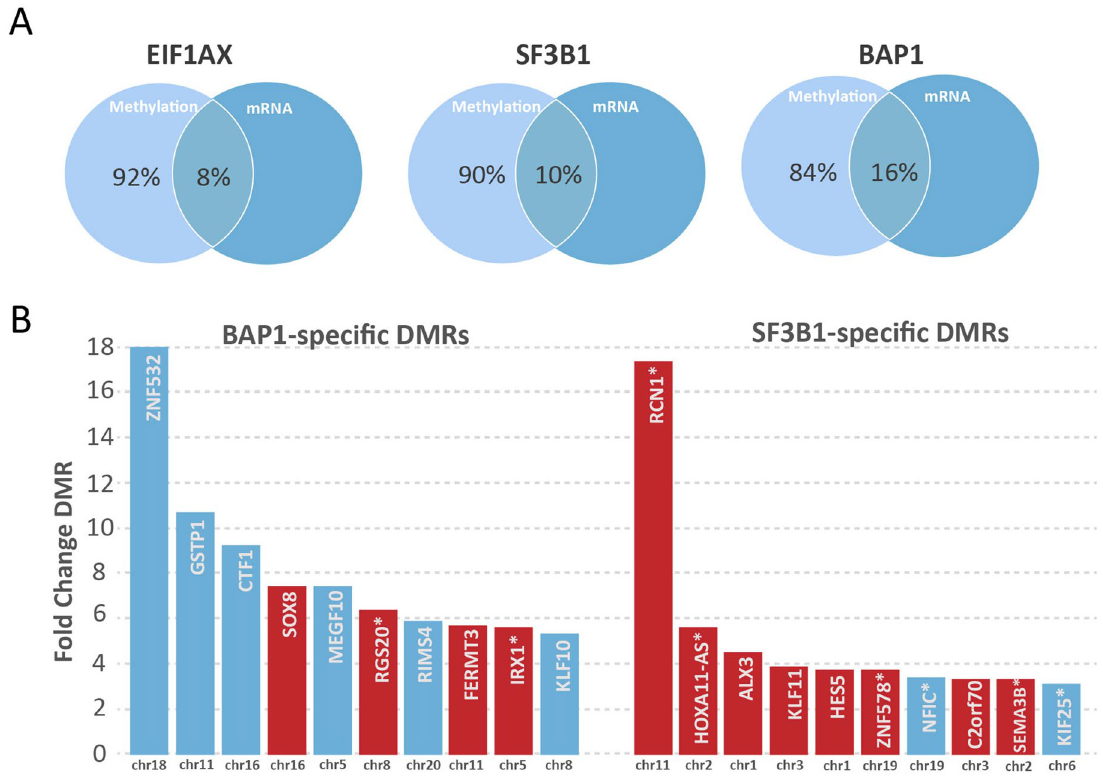
Figure 2. (A) The overlap of differential methylation with differential gene expression in the EIF1AX , SF3B1 and BAP1 group. ( B) The top ten most significantly methylated regions specific for the BAP1 -mutated, early metastasizing UM and the SF3B1-mutated, late metastasizing UM. Blue bars indicate downregulated expression, whereas red indicates upregulation of expression. Bars without an asterisk indicate differential methylation in promoters, whereas bars with an asterisk indicate differential methylation in the gene